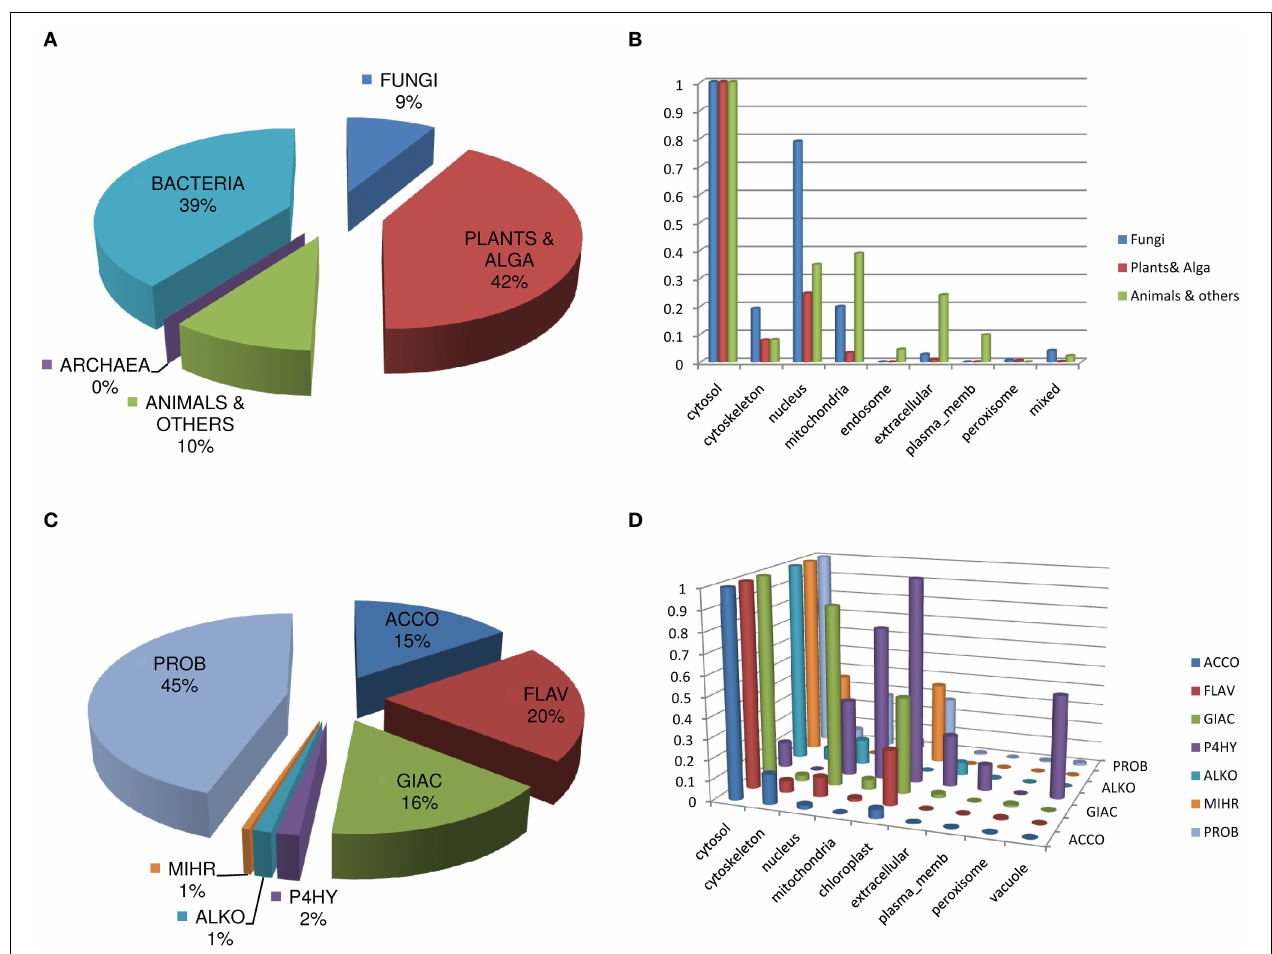
FIGURE 2 | Analysis and description of DB2OG. (A) Taxonomic distribution of sequences among all known kingdoms of life, (B) Predicted sub-cellular location of sequences using the PSORT suite of programs. (C) 2-OG dependent enzyme groups in plants ( n = 1624), with their (D) predicted cellular location. P4H, unlike the other groups has a compartmental preference, with appreciable numbers in the nuclear, mitochondrial, vacuolar, chloroplast, and extracellular regions of the cell. GA-oxidases have an almost comparable cytosolic and nuclear distribution. Data represent normalized values of the highest score for a particular cellular region in either plants, animal, or fungi (C) or 2OG-dependent enzyme clusters (D) . Abbreviations: ALKB, Alk-B like demethylase; ARGI, Arginine hydroxylase; ASPA,